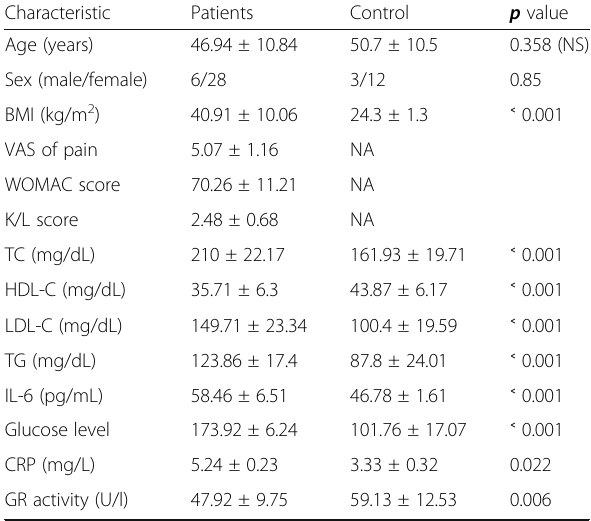
Table 1 Demographic, clinical, and laboratory data of the study